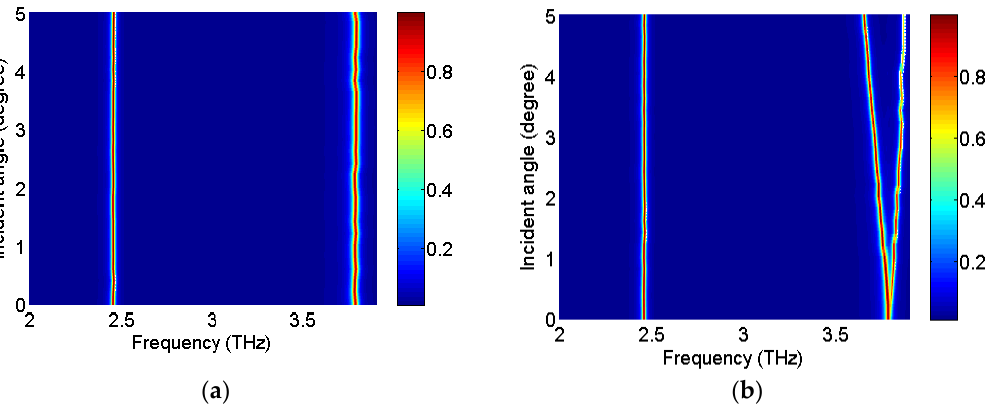
Figure 9. Simulated results of the proposed absorber with parameters presented in Table 1 under oblique incidence for ( a ) TE, and ( b ) TM polarization of the incident plane wave.